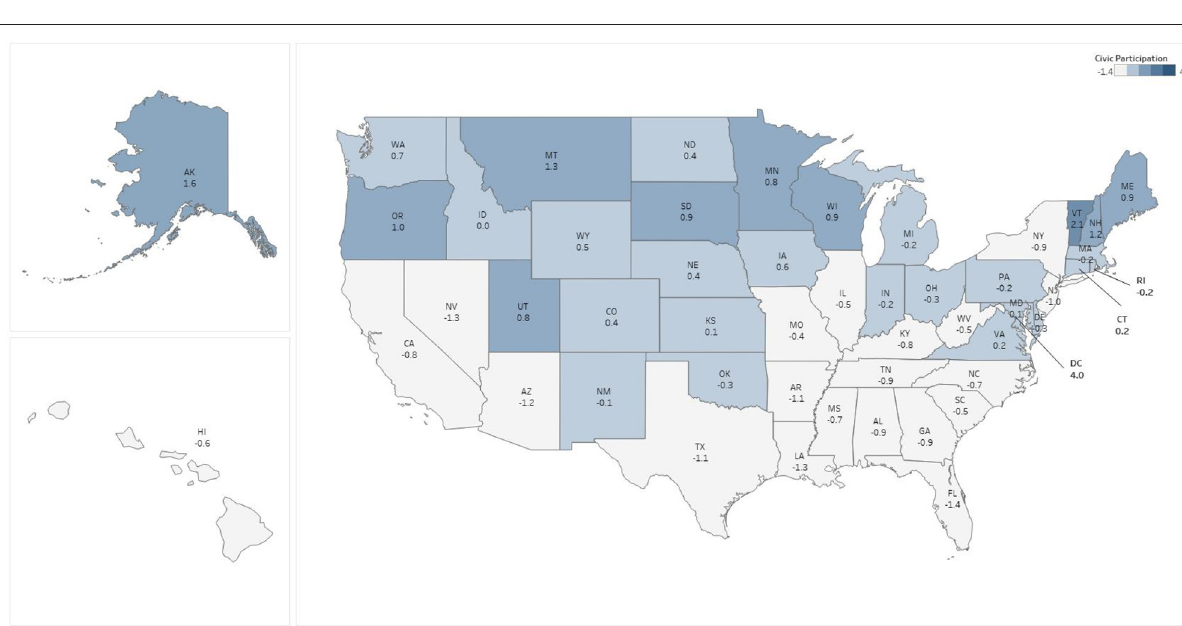
FIGURE 2 | Pre-pandemic civic participation by